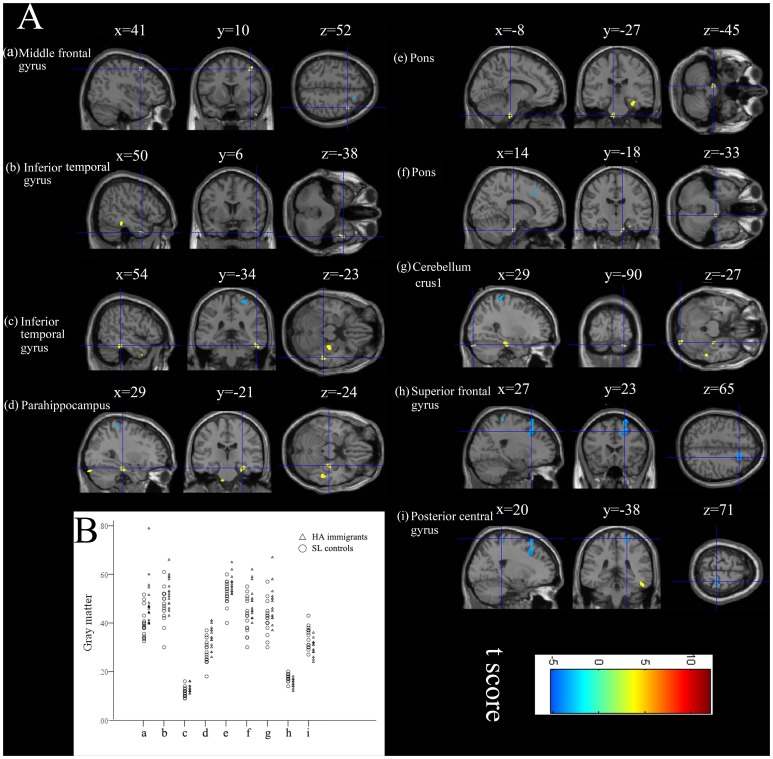
Changed gray matter volumes in HA immigrants compared with SL controls as revealed by voxel-based morphometry.(A) Three-dimensional slices depicting regions showing increased gray matter volume in the bilateral pons, and right cerebellum crus1 and decreased gray matter volume in right superior frontal gyrus and right posterior central gyrus overlaid on a T1-weighted MRI anatomical image in the stereotactic space of the MNI template. (B) Scatter plots show between-group changes in these clusters.